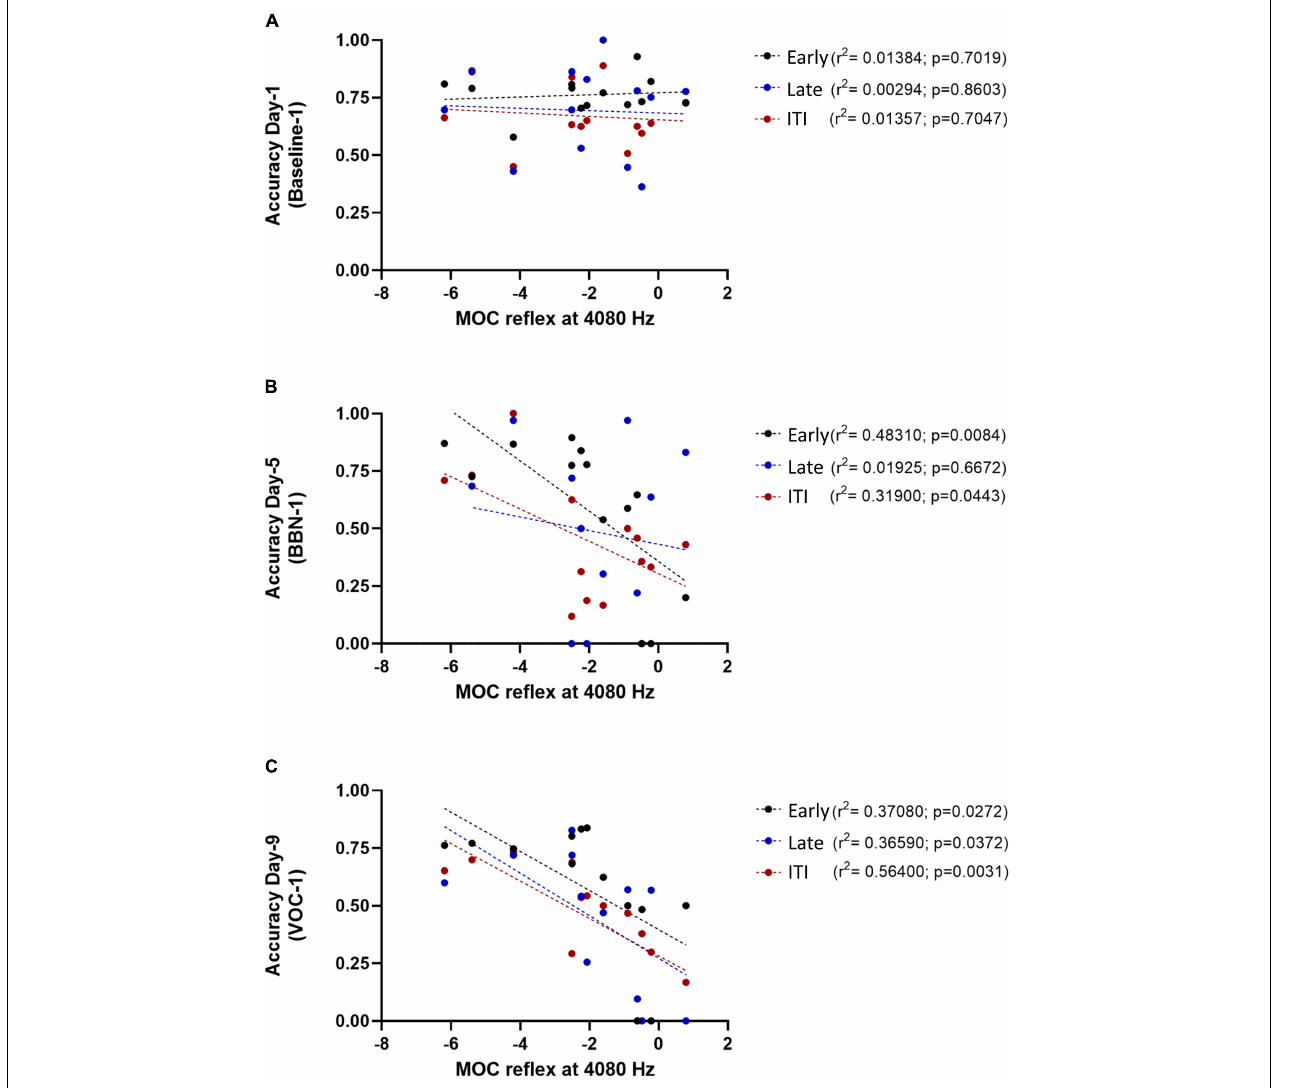
FIGURE 4 | Association between the MOC reflex (at 4080 Hz) and individual behavioral performance on different days of the behavioral protocol. The panel (A) represents the accuracy values on day 1 of the protocol (Baseline-1) as a function of the MOC reflex at 4080 Hz. In panel (B) it is shown the accuracy values on day 5 of the protocol (BBN-1) as a function of the MOC reflex at 4080, while panel (C) shows the values for day 9 of the protocol (VOC-1). The circles represent the individual values for each Chinchilla ( n = 13) and the dotted lines correspond to the fitting curve. Black circles correspond to early responses, blue ones to the late response and red circles to ITI